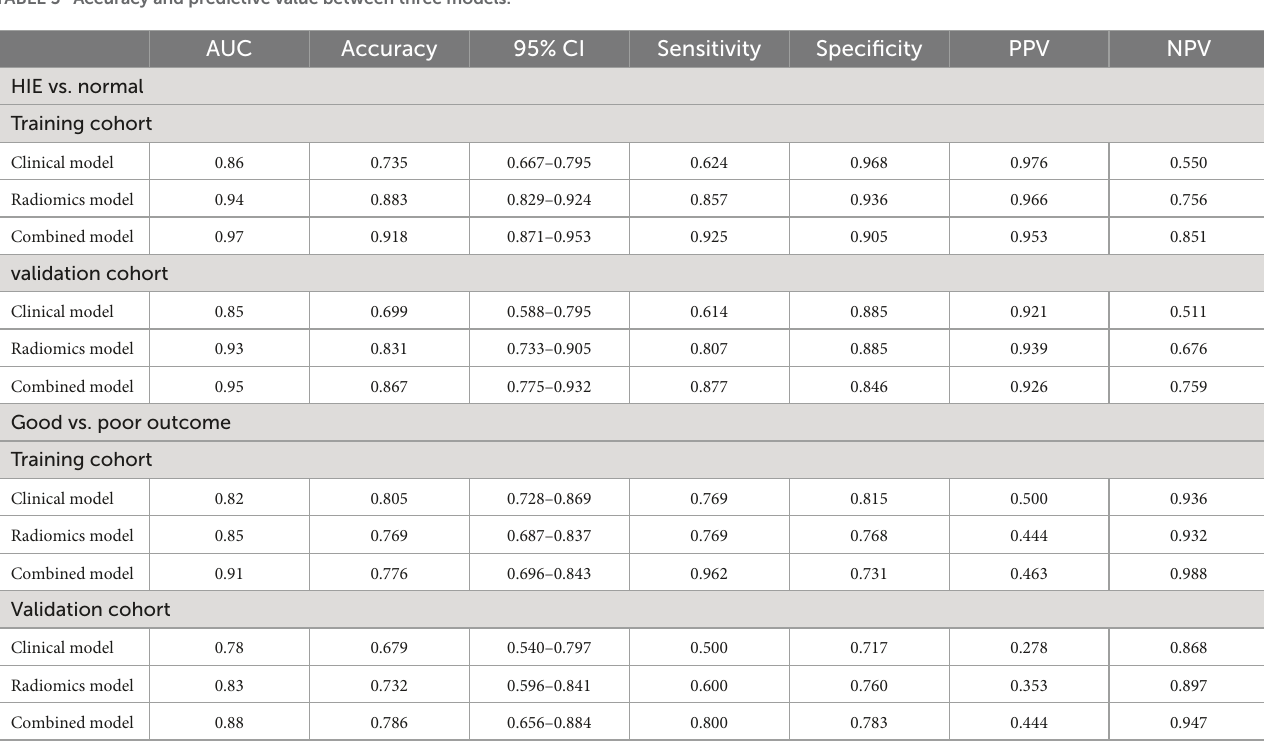
TABLE 5 Accuracy and predictive value between three models. AUC Accuracy 95% CI Sensitivity Specificity PPV NPV HIE vs.